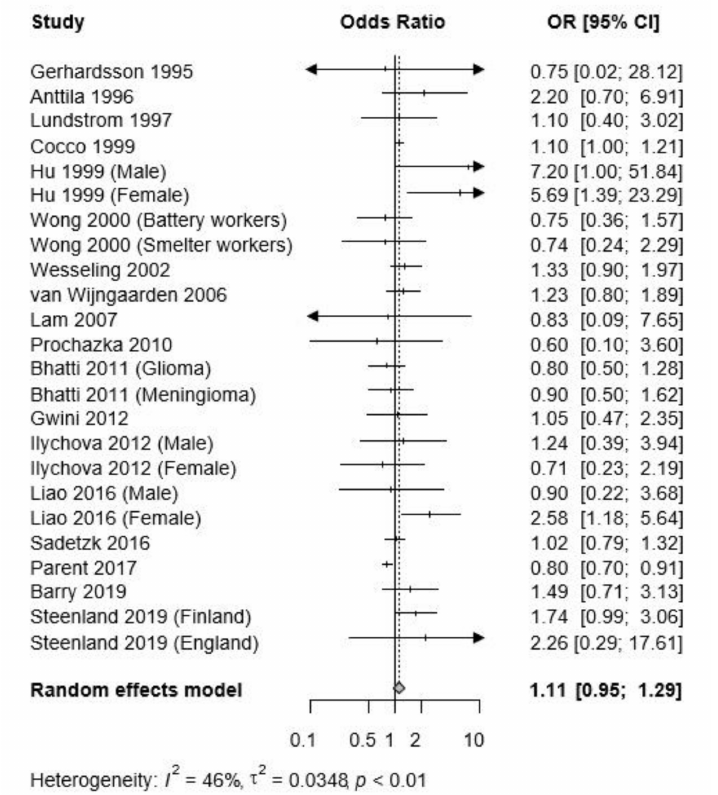
Figure 2. Forest plot of the risk estimates, log odds ratios (OR), and 95% confidence intervals (CI) from the studies included in the meta-analysis of the association between occupational lead exposure and all brain